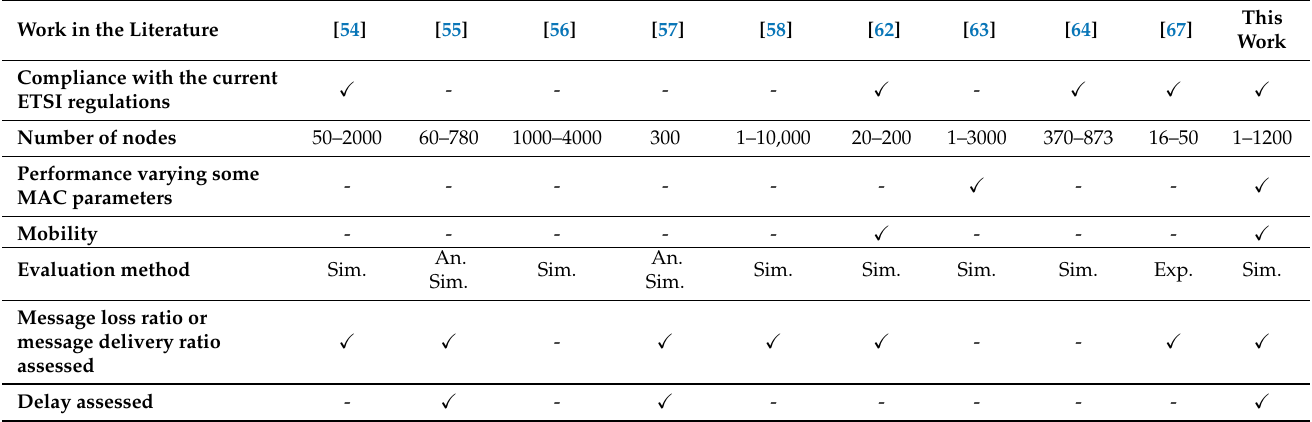
Table 1. Comparison of relevant works in the